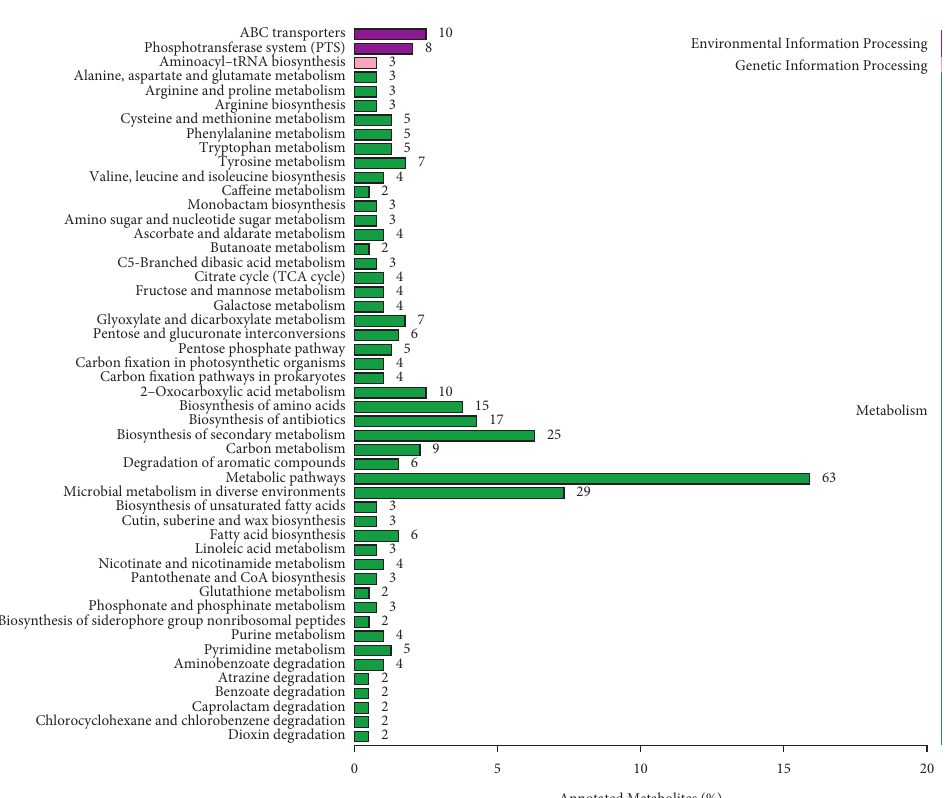
Figure 4: The annotated and classified results of the differential metabolite in the KEGG